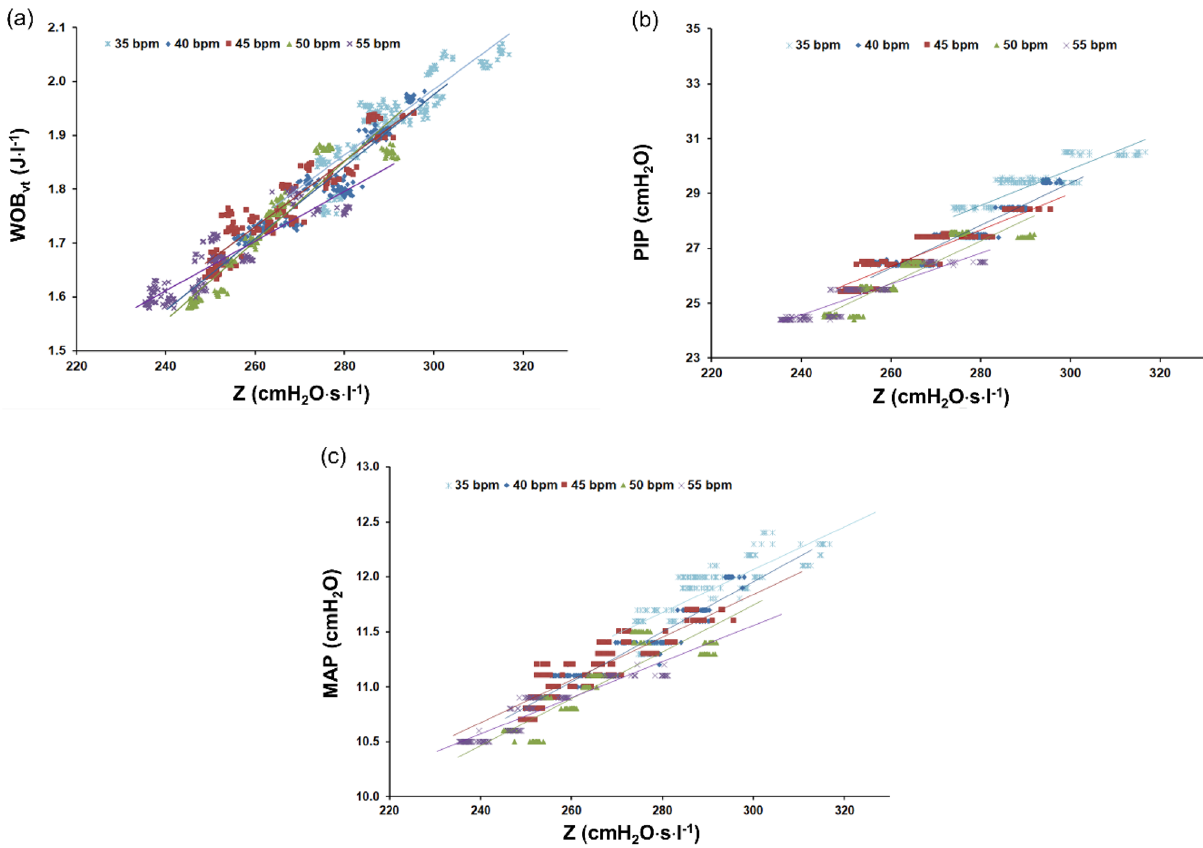
Figure 4. Relationship between: work of breathing (WOB vt ) and respiratory system impedance (Z) ( a ), peak inspiratory pressure (PIP) and Z ( b ), and mean airway pressure (MAP) and Z ( c ). P 3 : R = 205 cmH 2 O·s/l, R C = 131 cmH 2 O·s/l, R 1 = R 2 = 88 cmH 2 O·s/l, C = 1.14 ml/cmH 2 O, C w /C L =